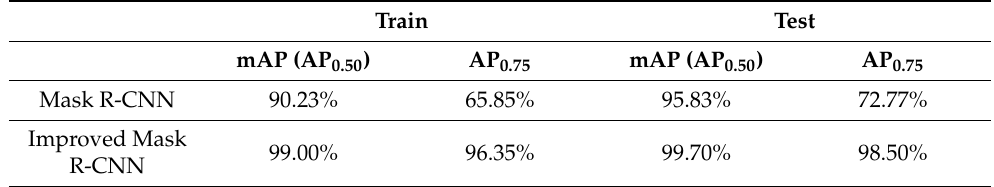
Table 6. Results of mean average